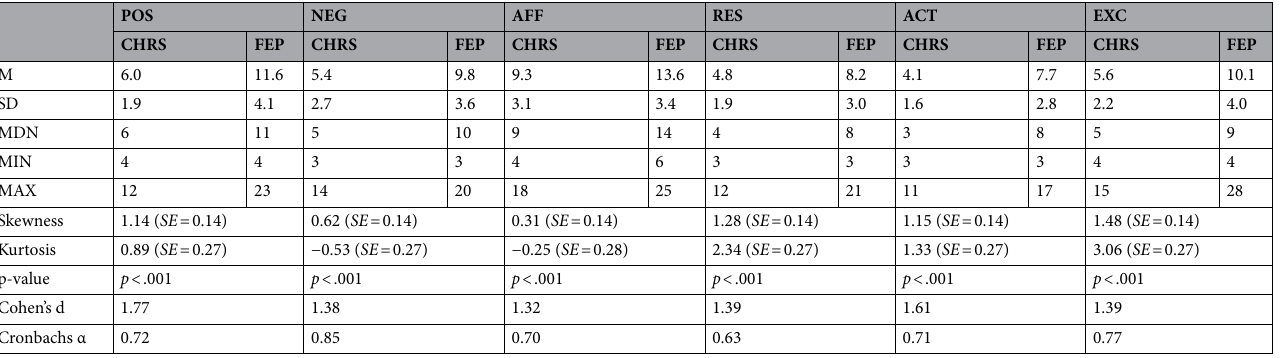
Table 1. Descriptive statistics of BPRS baseline scores. BPRS Brief Psychiatric Rating Scale, POS Positive Symptoms (items: unusual thought content, conceptual disorganization, hallucinatory behavior, grandiosity; theoretical range: 4–28), NEG Negative Symptoms (items: blunted affect, emotional withdrawal, motor retardation; theoretical range: 3–21), AFF Affectivity (items: anxiety, guilt feelings, depressive mood, somatic concern; theoretical range: 4–28), RES Resistance (items: hostility, uncooperativeness, suspiciousness; theoretical range: 3–21), ACT Activation (items: excitement, tension, mannerisms-posturing; theoretical range: 3–21), EXC Excitement (items: excitement, hostility, uncooperativeness, tension; theoretical range: 4–28), CHRS Clinical High-Risk State subjects, FEP First Episode Psychosis individuals, M mean value, SD standard deviation, MDN median, MIN minimum, MAX maximum, SE standard error.